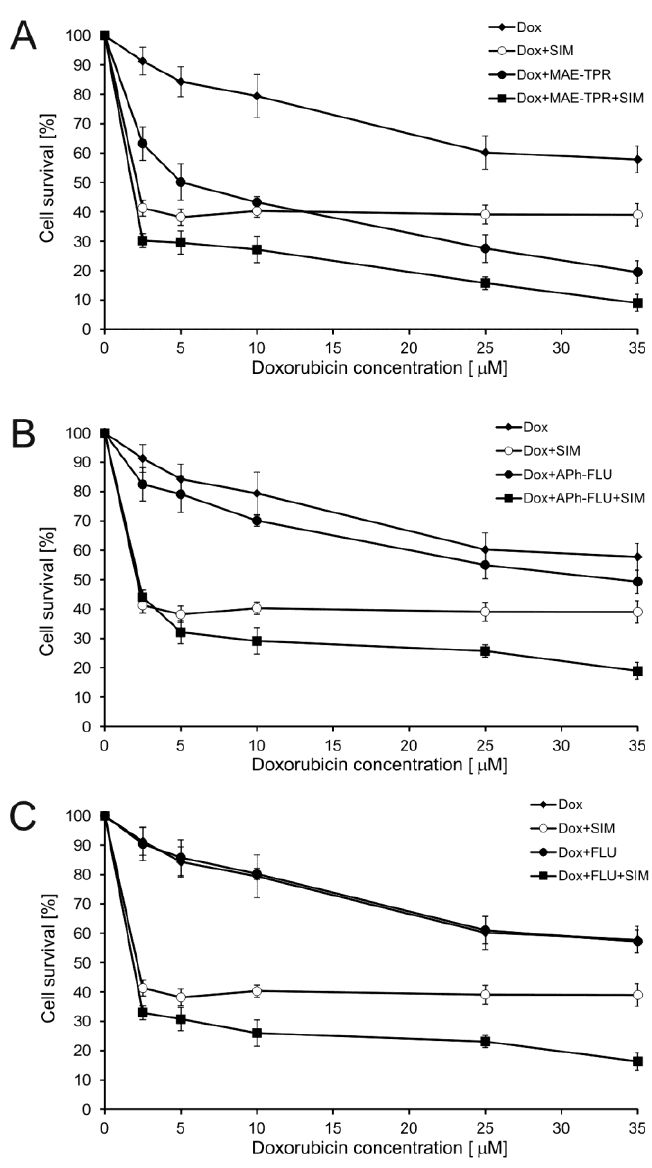
Figure 2. Cytotoxicity of doxorubicin (Dox) (diamonds), Dox, combined with simvastatin (SIM) at 2.5 µ M (empty circles), Dox combined with phenothiazine derivative at 2.5 µ M (full circles) and Dox combined with phenothiazine derivative at 2.5 µ M and simvastatin at 2.5 µ M (squares) to LoVo/Dx cells. The means of three experiments ± SD are presented.